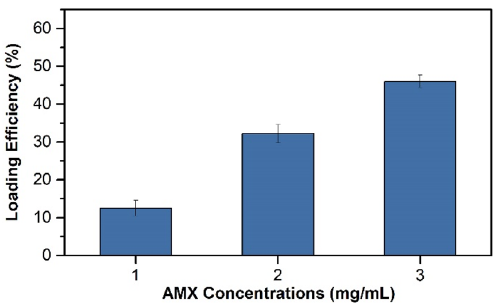
Figure 1. Loading efficiency of AMX in LAP nanoplates at different